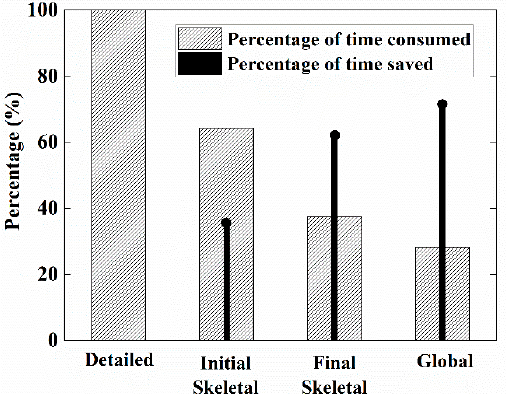
Figure 8. Comparison of the calculation consumption of detailed, initial skeletal, final skeletal and global mechanisms.